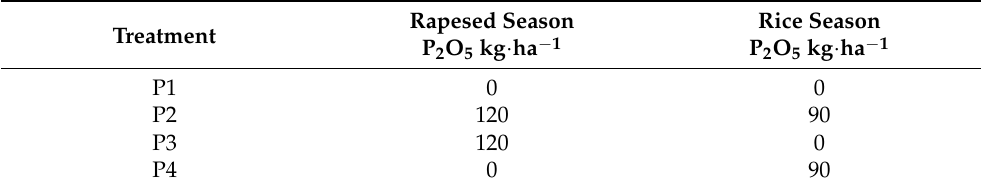
Table 1. Phosphorus application amount in winter rape-rice rotation system under different P application